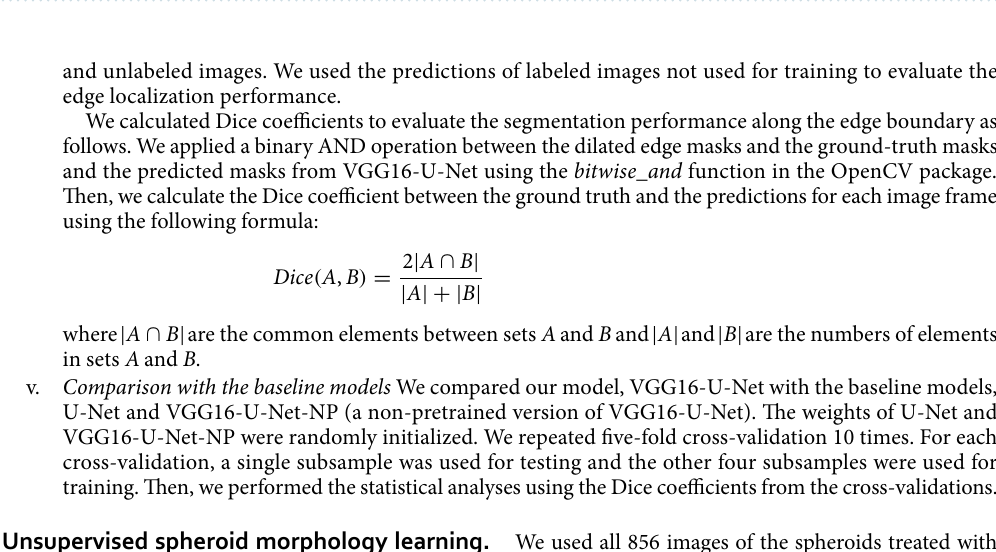
Table 1. The numbers of images used for unsupervised spheroid morphology